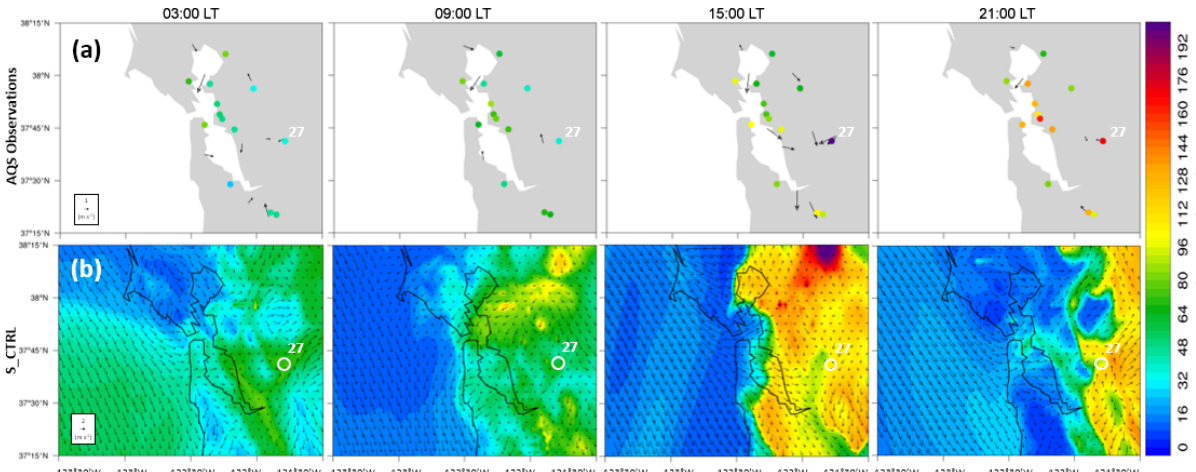
Figure 10. Surface PM 2 . 5 and wind field of observations (a) and S_CTRL predictions (b) on 14 November in the Bay Area. Note that the reference wind vector for S_CTRL is 2ms − 1 , while the reference is 1ms − 1 for observations. While the plume encroaches on the Bay Area, a strong sea breeze develops midday, driving plumes back inland. This sea breeze is not present in observational data, leading to a large underprediction of surface PM 2 . 5 .